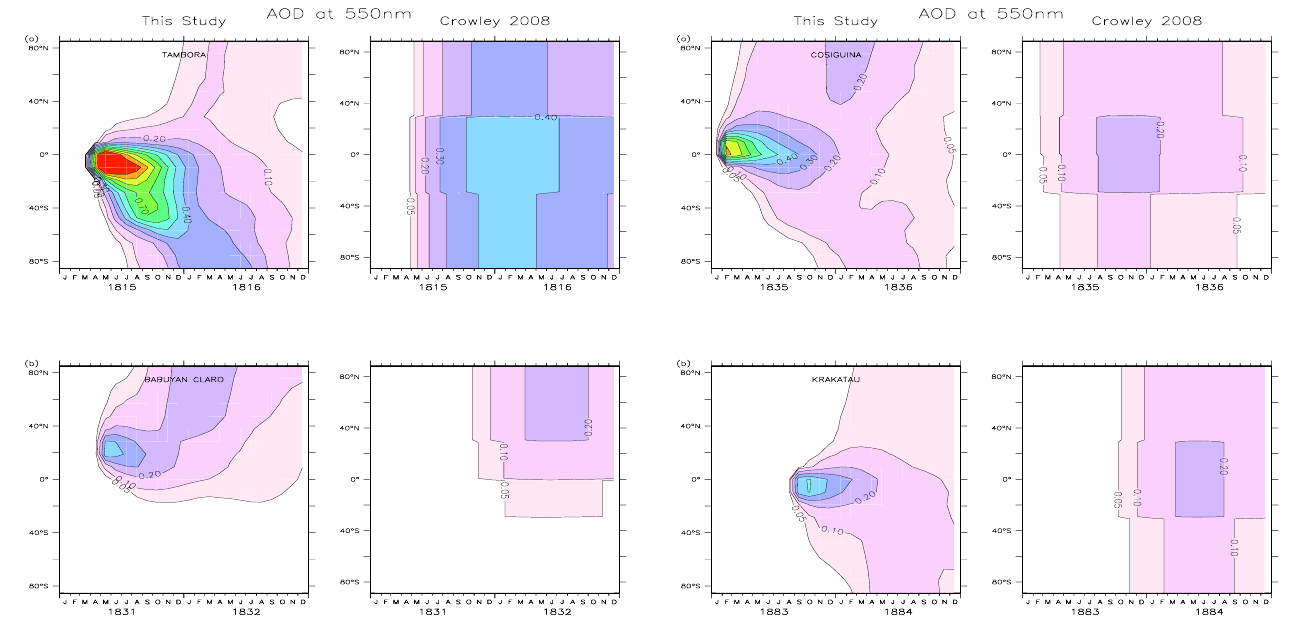
Fig. 6. Latitudinal distribution of the optical depth in VIS (550nm) for the Tambora (1815) and Babuyan Claro (1831) eruptions for this study (left column) and Crowley et al. (2008) (right column).